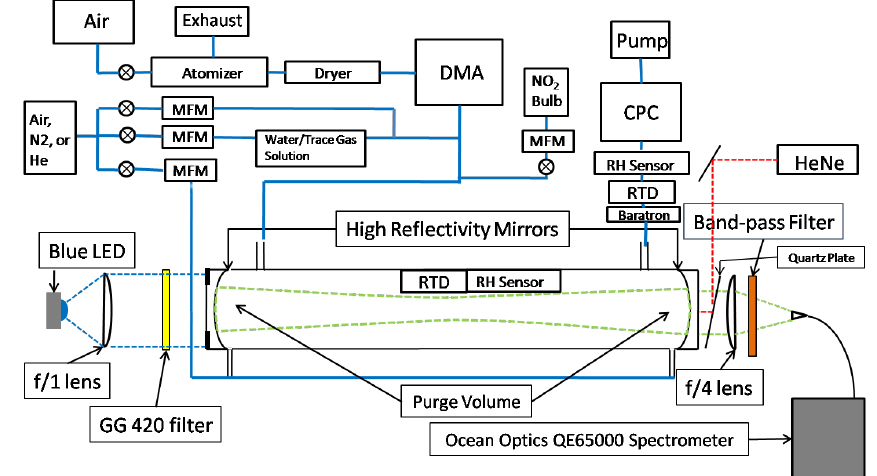
Fig. 2. Schematic of cavity set up and block diagram of flow handling system for aerosol delivery.